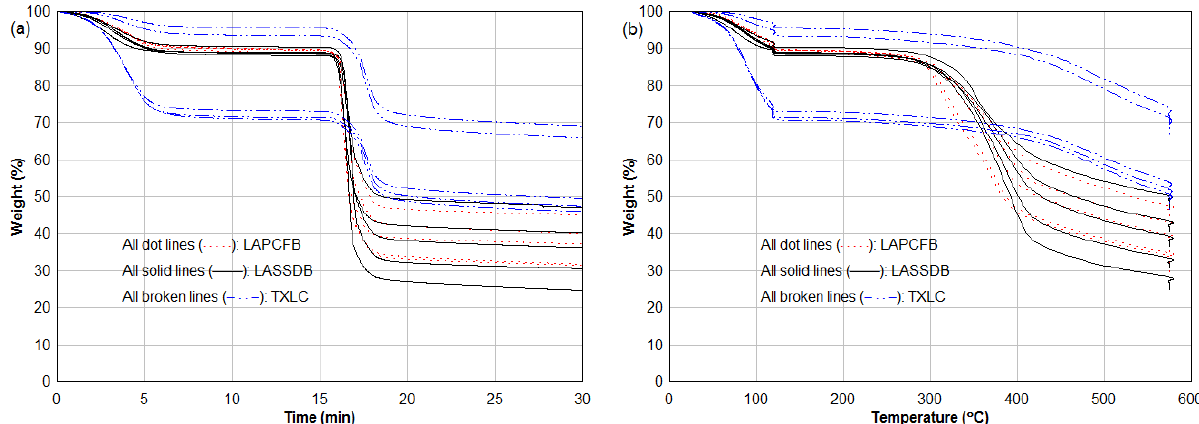
Figure 6. Pyrolysis results using TGA for different particle sizes of LASSDB: ( a ) weight % vs. time with particle size as the parameter and ( b ) weight % vs. temperature with particle size as the parameter.